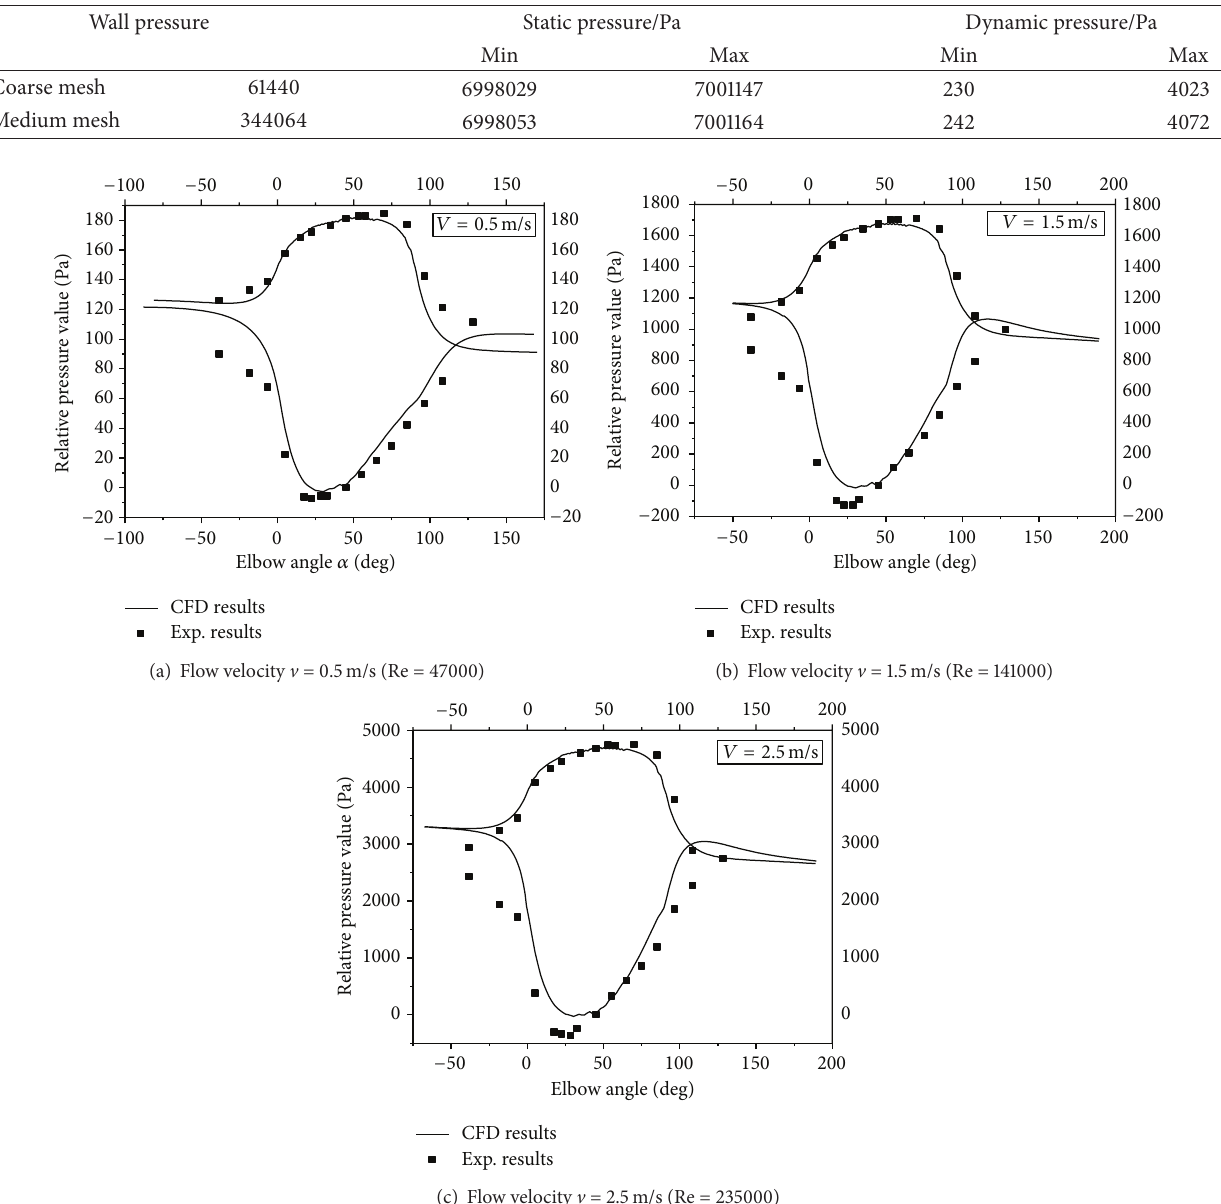
Figure 4: Comparison of the measured and predicted static pressure profile of 90 ∘